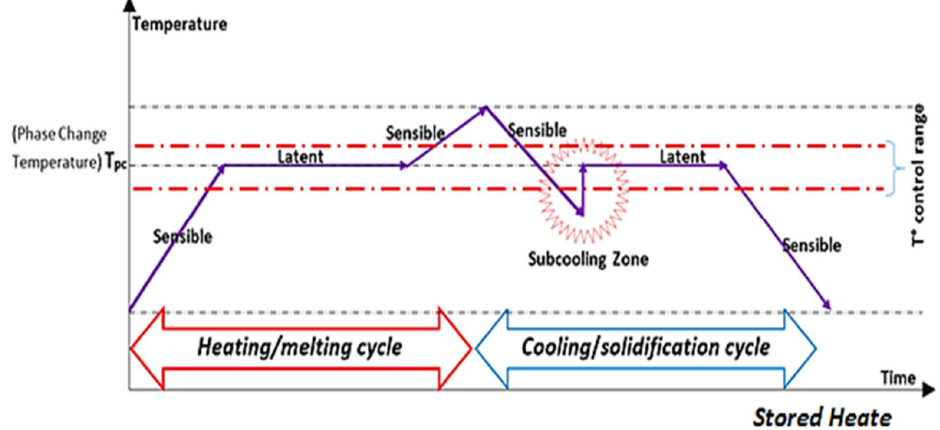
Figure 1. Diagram of temperature change through heating and cooling of a Phase Change Material (PCM) (general case).